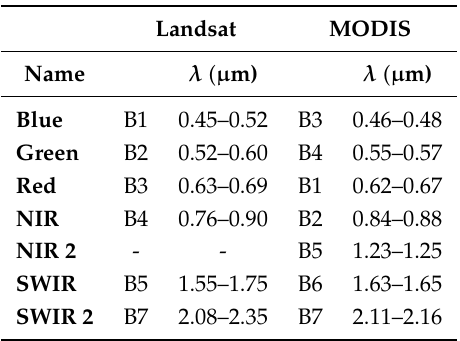
Table 1. Specification of spectral bands for sensors Landsat and